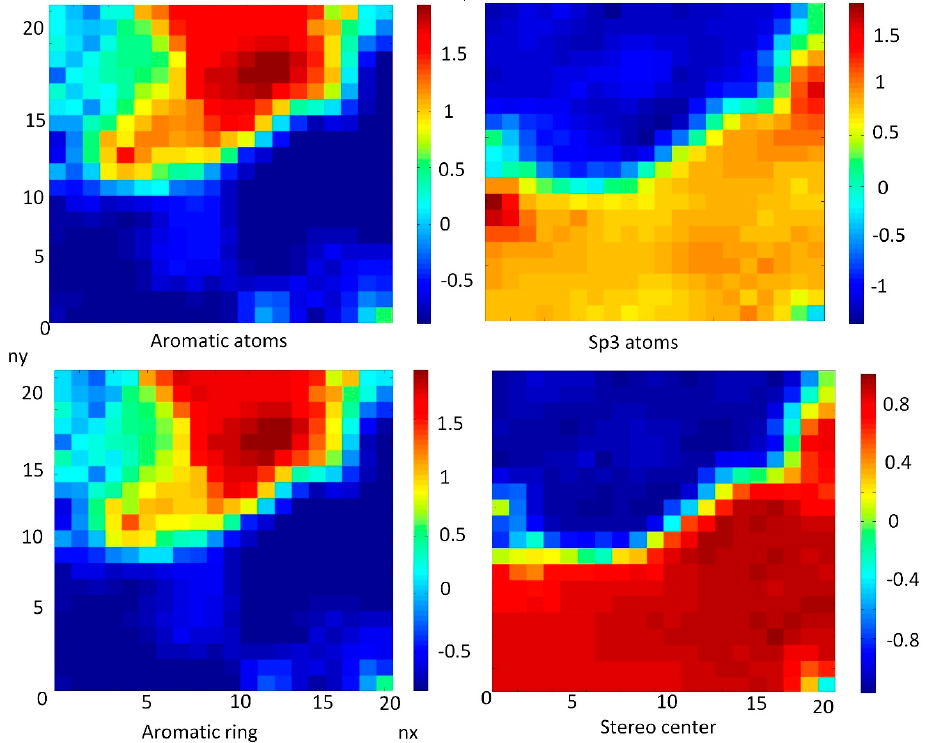
Figure 7. Weight maps for correlated descriptors for aromatic rings and atoms: aromatic atoms, aromatic rings, sp3-atoms, and stereo centers.